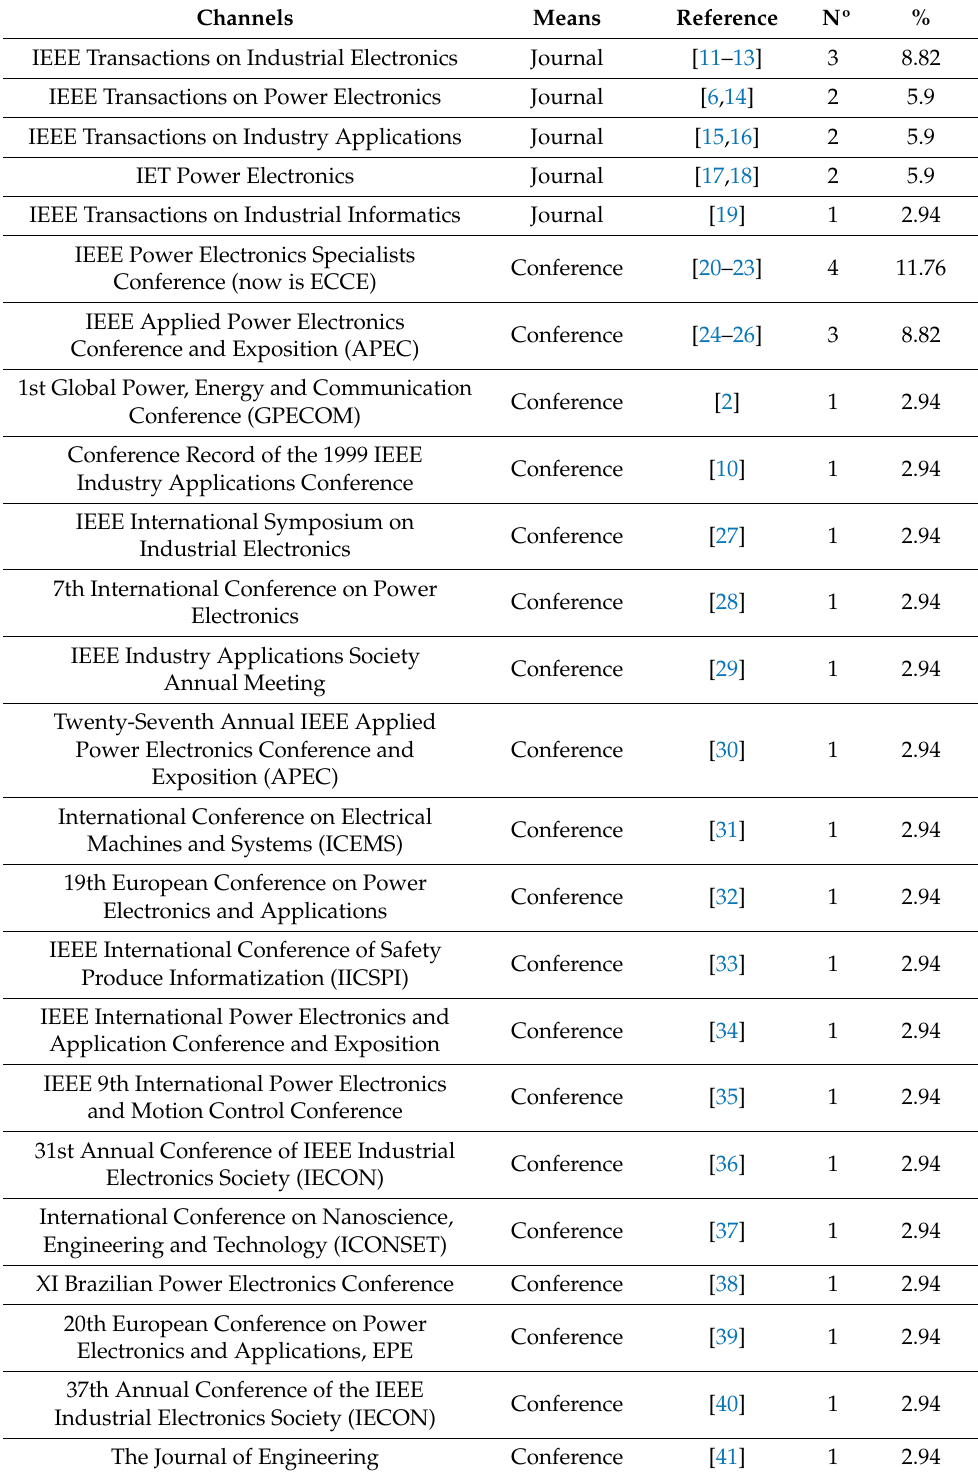
Table 3. Publication